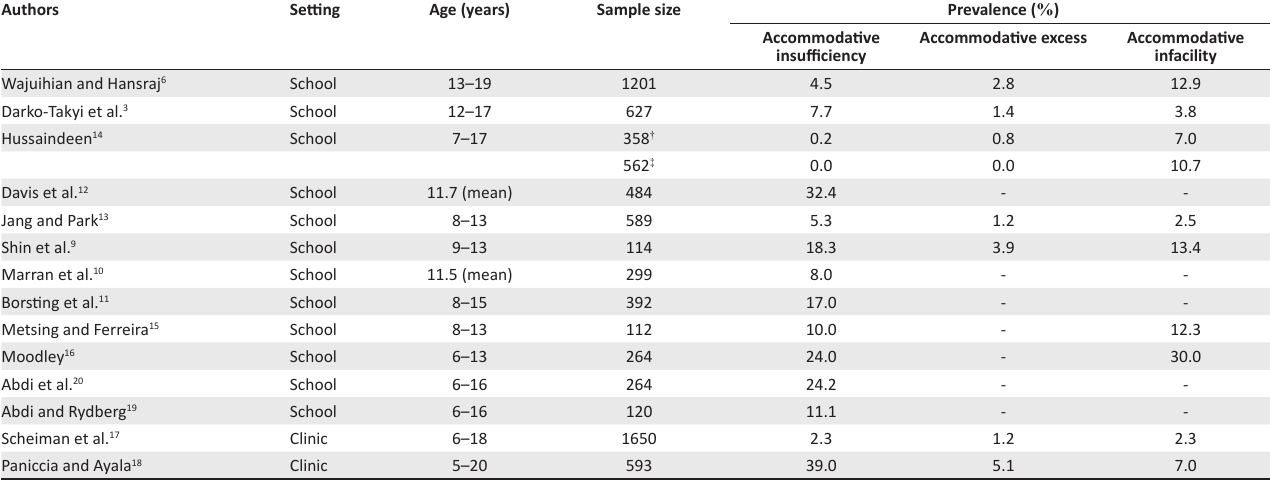
TABLE 1: A summary of studies reporting the prevalence ( % ) of accommodative anomalies in school-age children. Authors